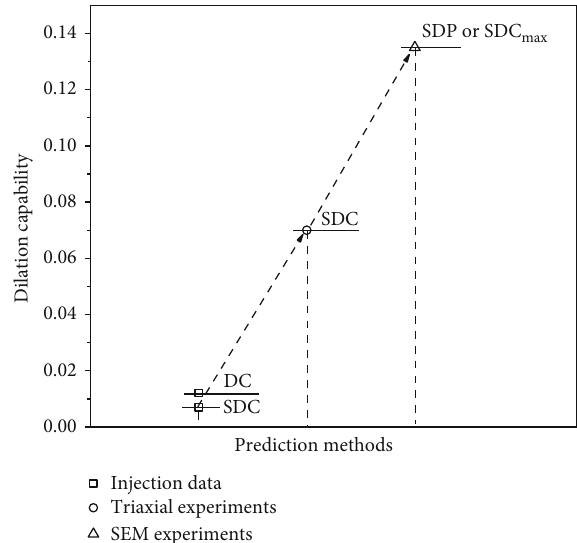
Figure 22: Comparison of shear dilation capabilities evaluated by di ff erent